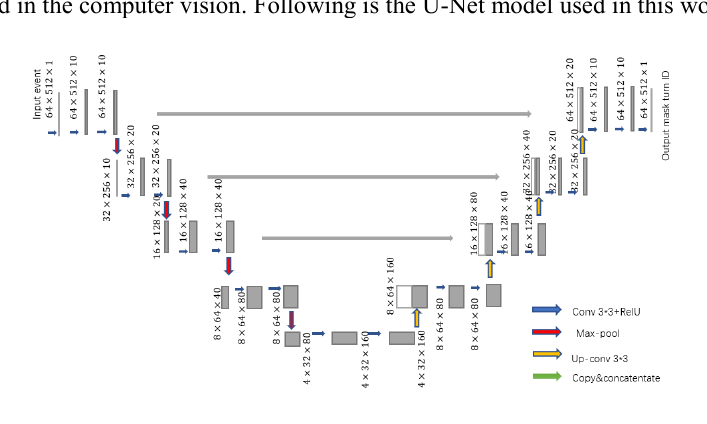
Fig.6 . The feature and target matrixes of one